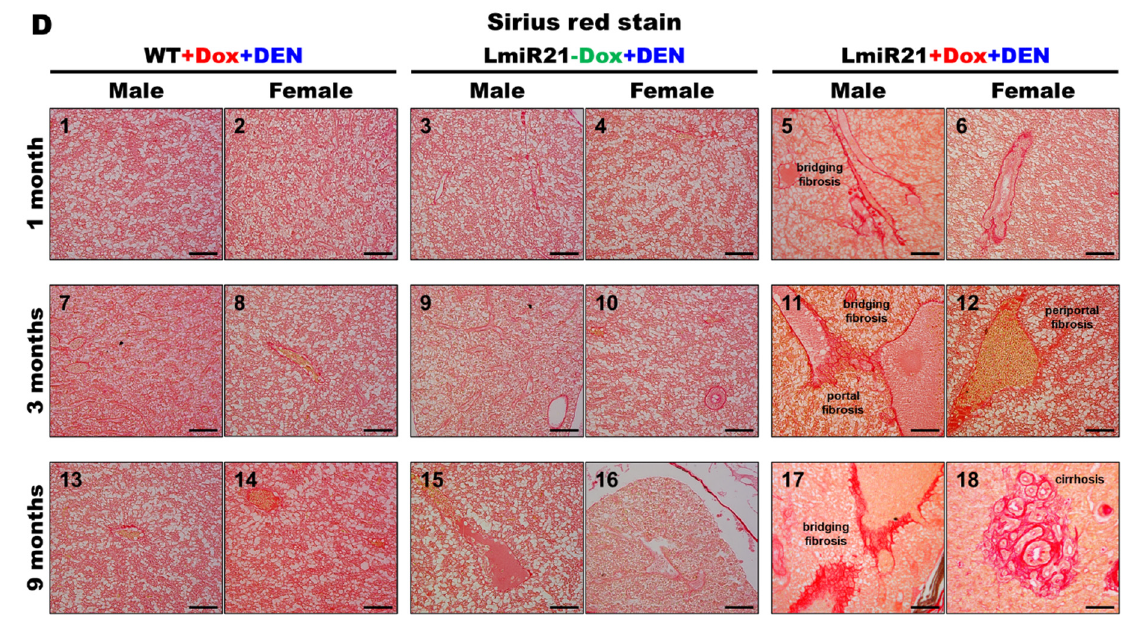
Figure 6. Increased susceptibility of LmiR21 zebrafish to diethylnitrosamine (DEN)-induced liver fibrosis and carcinogenesis. ( A ) Experimental design of three independent DEN treatments and doxycycline (Dox) dosing. ( B ) Representative images of livers with microscopic tumors identified following hematoxylin & eosin staining (indicated with arrows) one, three, and nine months after DEN treatment. Scale bar: 100 µ m. ( C ) Representative images of livers with microscopic injuries identified by Masson’s trichome staining at one, three, and nine months after DEN treatment. Scale bar: 50 µ m. ( D ) Representative images of livers with microscopic injuries identified by Sirius red staining at one, three, and nine months after DEN treatment. Scale bar: 50 µ m. The authors apologize for any inconvenience caused and state that the scientific conclusions are unaffected. The original article has been